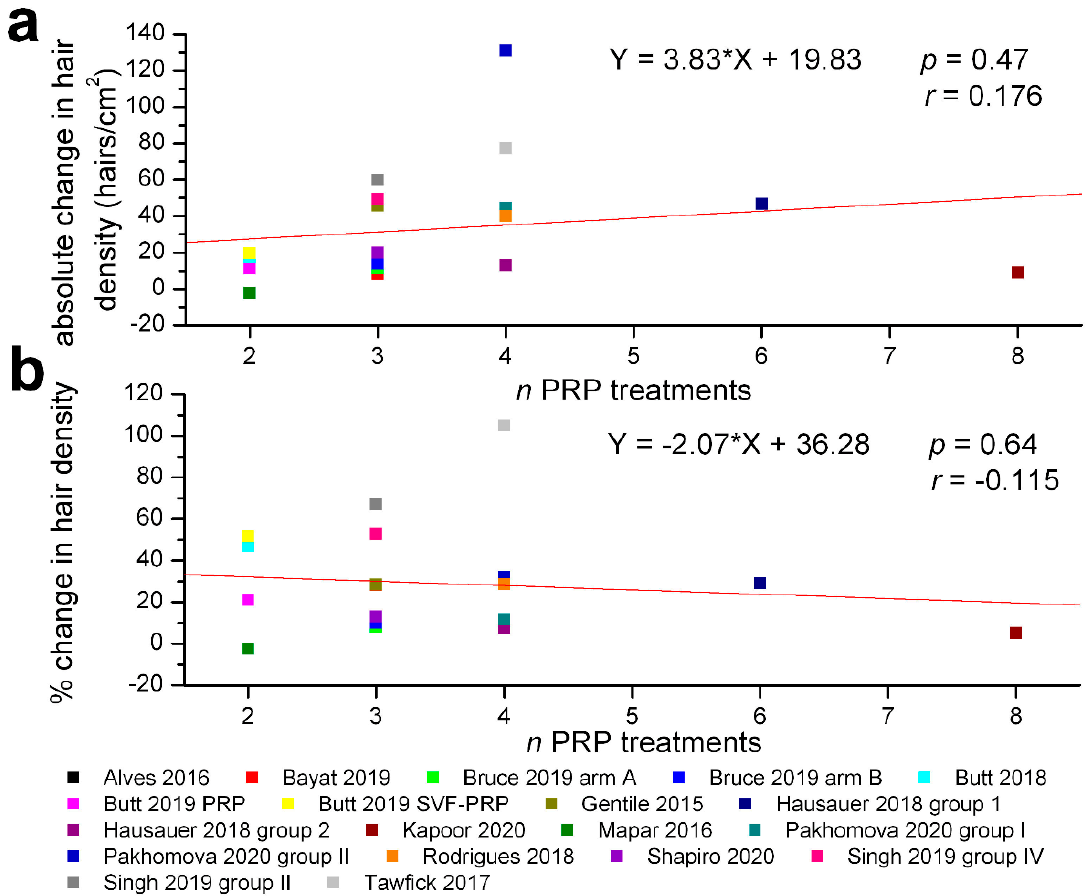
Figure 4. Absence of significant correlations between the number of PRP treatments and absolute or percentage change in hair density within the clinical trials selected for meta-analysis. ( a ) absolute changes in hair density (hairs/cm 2 ) at the end of evaluation period. ( b ) percentage changes in hair density relative to initial values (same legend for both graphs). The regression lines are plotted in red, and the corresponding equations, values of correlation coefficients r and their probabilities p are marked on each graph.